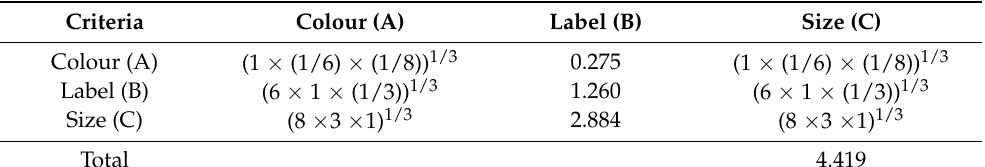
Table 11. Normalization table.